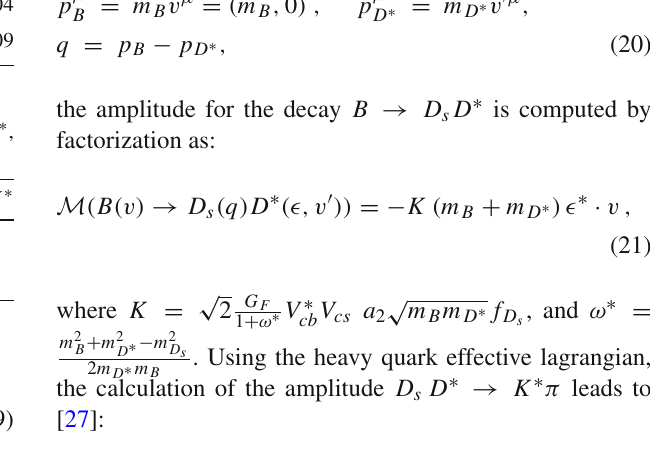
where the integration is over the solid angle. Using the fol- lowing kinematics: